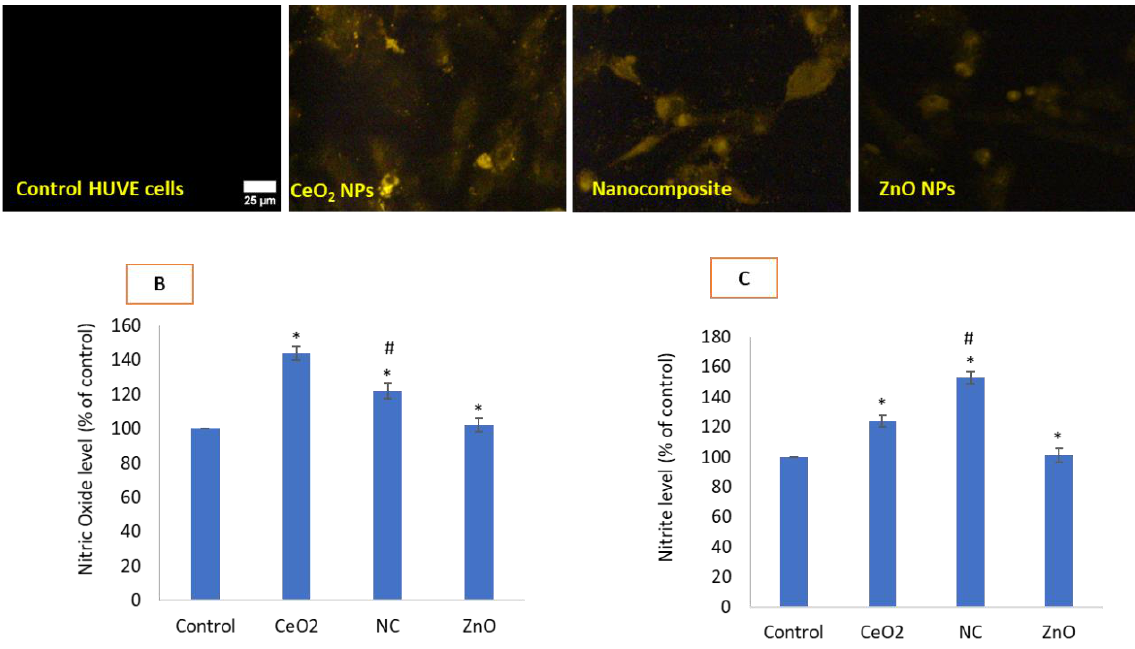
Figure 5. Potential generation of NO in HUVEC cells due to various NP treatments was evaluated by DAR-2 imaging in infra-red region (see images under DAR-2 in Figure ( A )) and its quantification ( B ). NO was also determined by indirectly quantifying nitrites by Griess reagent ( C ). Scale bar represents 25 µ m. Each image was captured by a 40 × objective under uniform conditions of illumination intensity, time and other variables. Each experiment was performed in triplicates ( n = 3). * statistically significant difference from the control ( p < 0.05). # statistically significant difference in between treatments of CeO 2 -Zn nanocomposite and ZnO NP ( p < 0.05).